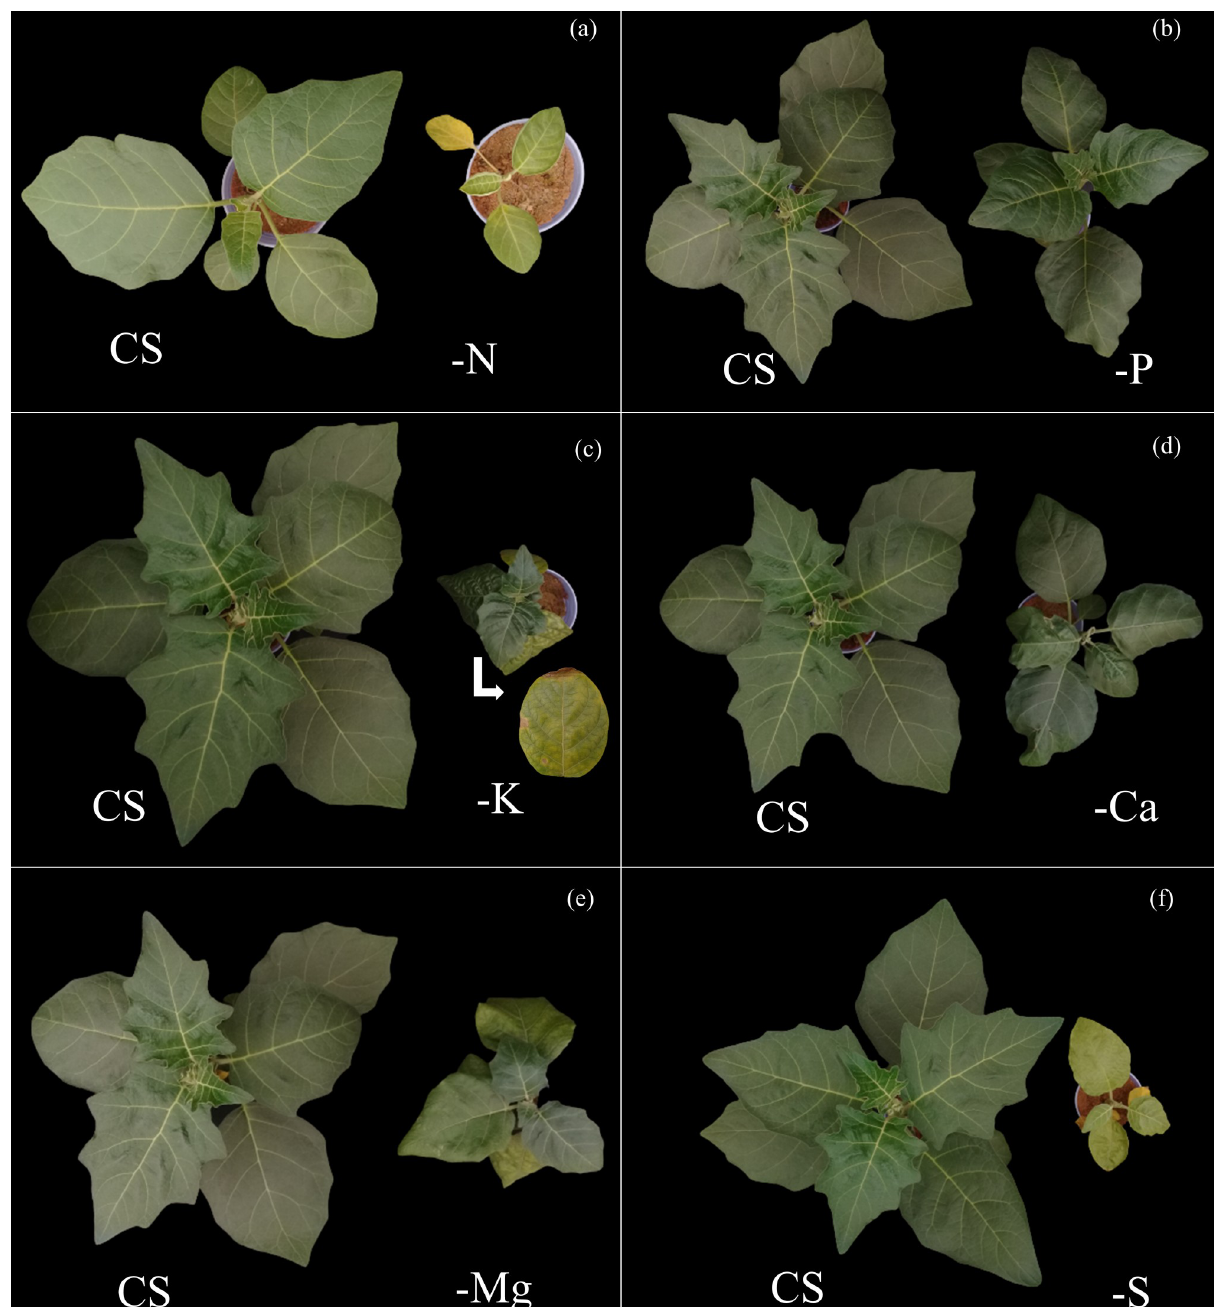
Fig 7. Top view of scarlet eggplants with visual symptoms of nitrogen deficiency (-N) (a), phosphorus (-P) (b), potassium (-K) (c), calcium (-Ca) (d), magnesium (-Mg) (e) and sulphur (-S) (f) compared to the complete solution (CS). https://doi.org/10.1371/journal.pone.0252866.g007 to CS, respectively (Fig 5E and 5F). The symptoms related to K deficiency were characterized by an interruption of growth, as well as irregularities in the limb of leaves and yellowing of its edges, with an advanced symptomatology revealing chlorotic spots suffering necrosis (Figs 6C and 7C).